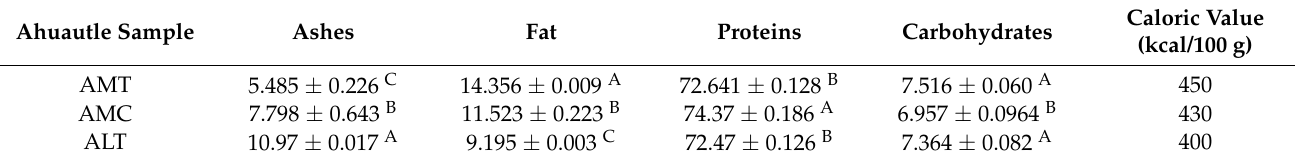
Table 2. Macronutrients in three different samples of corixidae eggs (g/100 g dry basis). Ahuautle Sample Ashes Fat